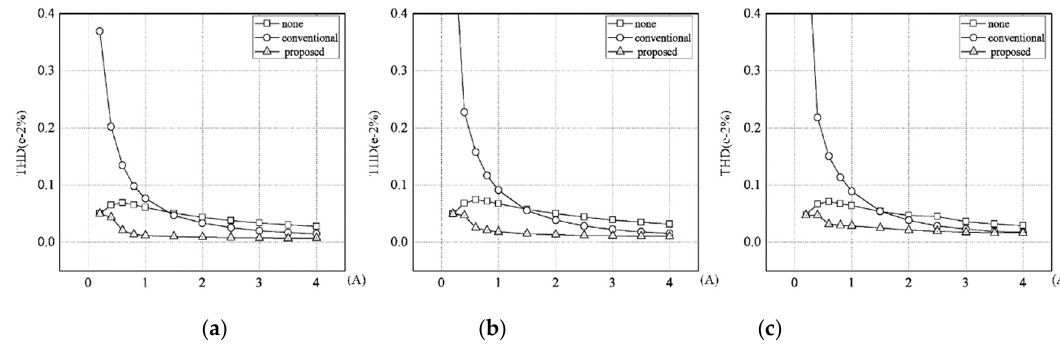
Figure 31. Comparing the a-phase current THD; ( a ) 10 Hz; ( b ) 30 Hz; ( c ) 50 Hz.